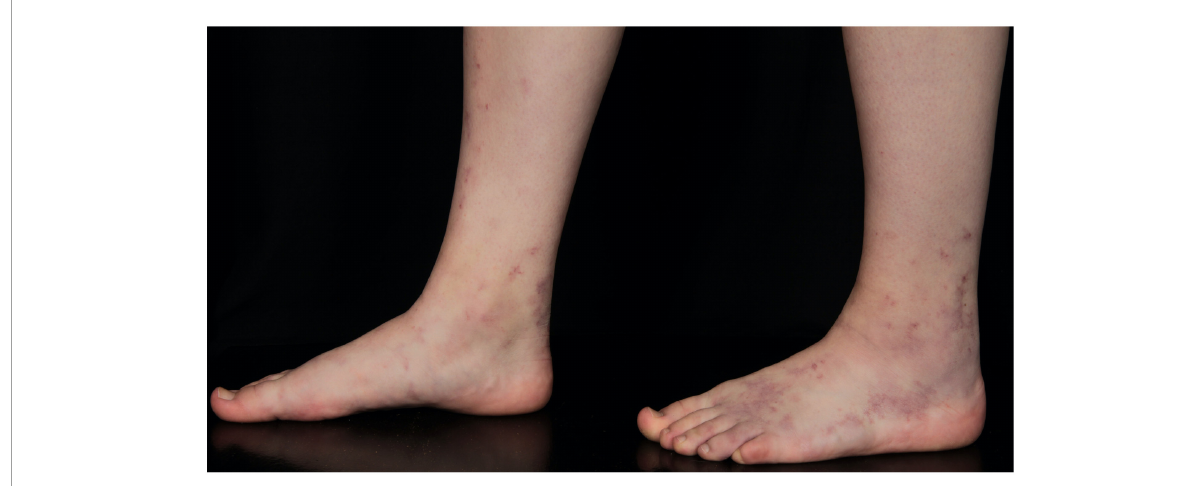
FIGURE5 16-year old female patient with initial lesions of LV.